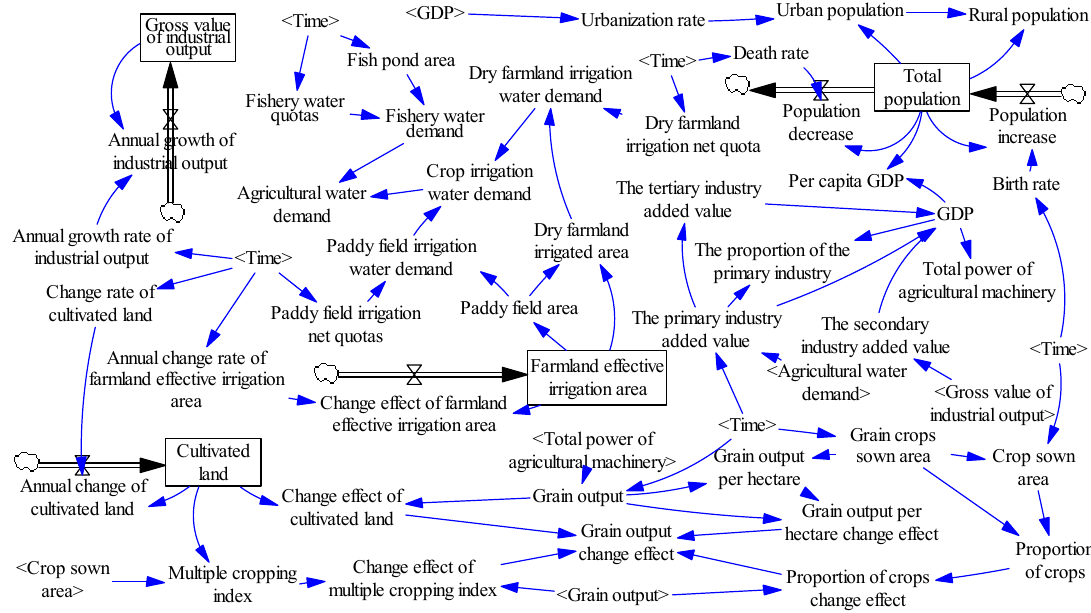
Figure 1. SD (System Dynamics) model of grain production in Heilongjiang Province.